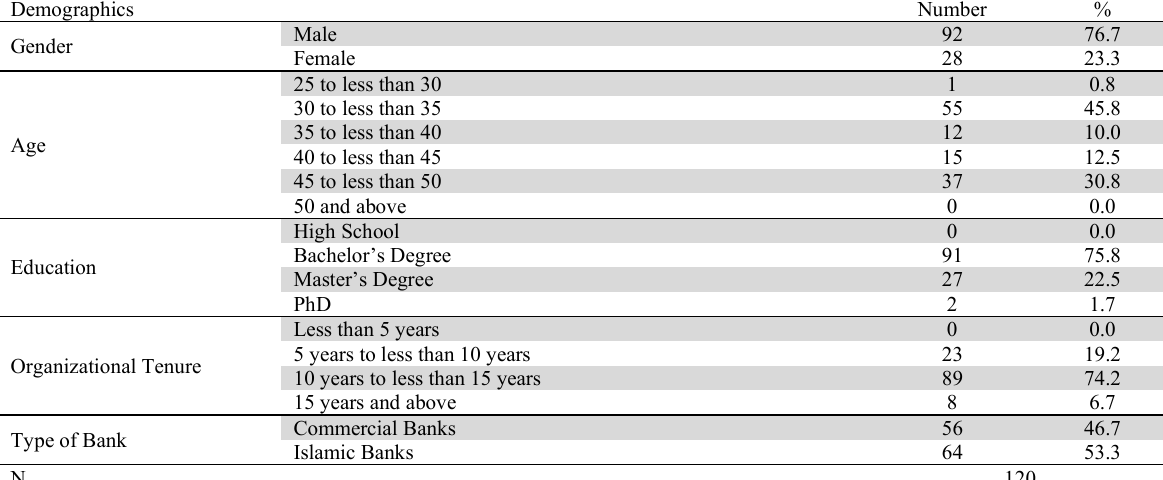
Demographic characteristics of the